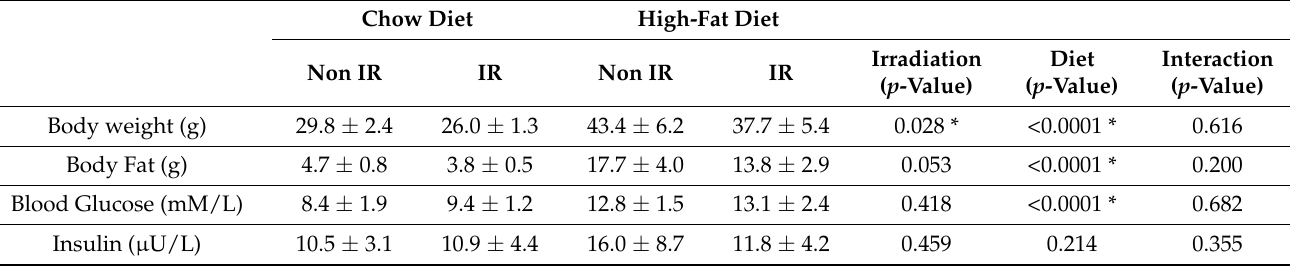
Table 1. Metabolic data at 17 weeks